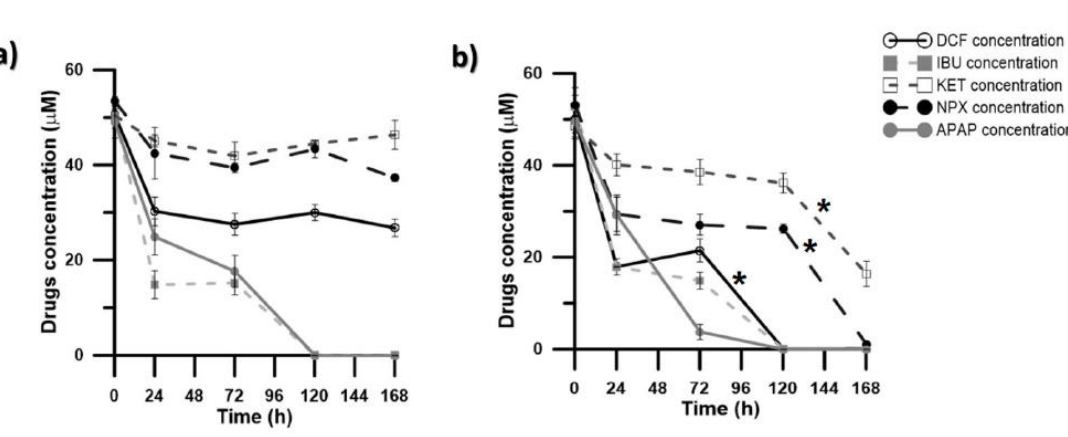
Figure2. Biodegradationofacomplexmixofnon-steroidalanti-inflammatorydrugs(NSAIDs) / analgesic by Penicillium oxalicum at Figure 2. Biodegradation of a complex mix of non-steroidal anti-inflammatory drugs